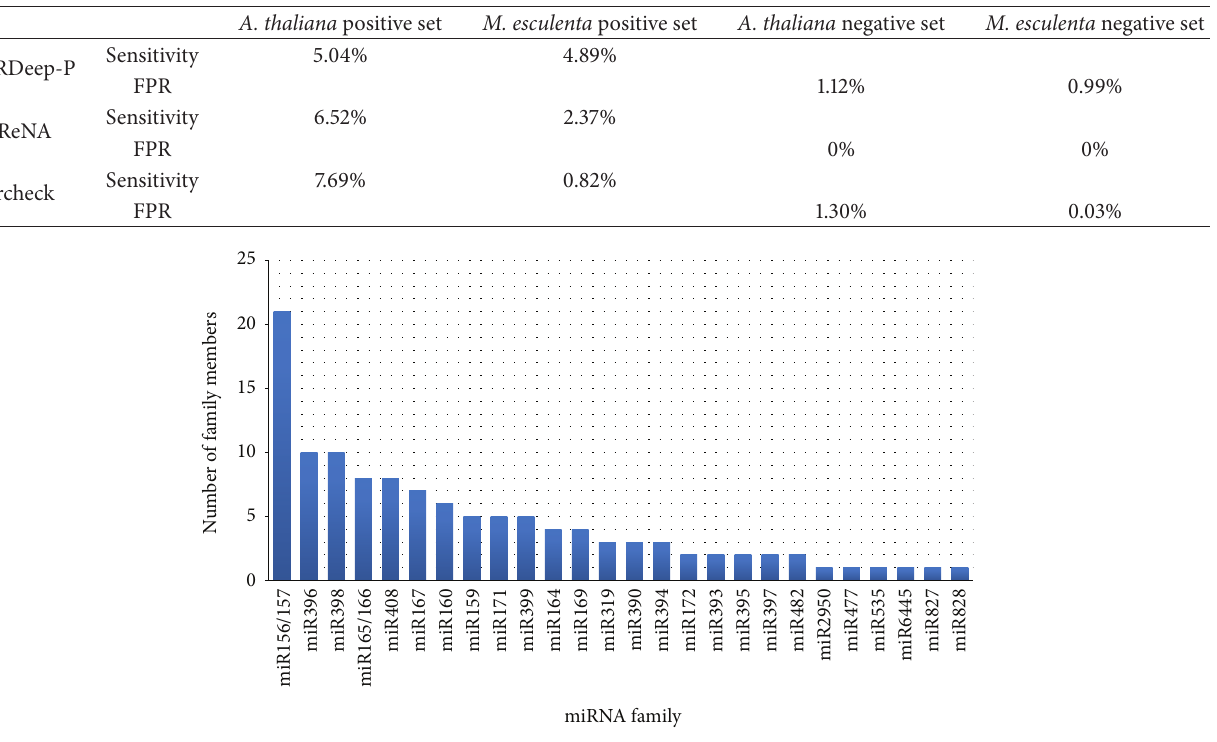
Figure 3: Distribution of 60 conserved cassava miRNAs grouped in 26 different families. Names correspond to homologous small RNAs in other plant